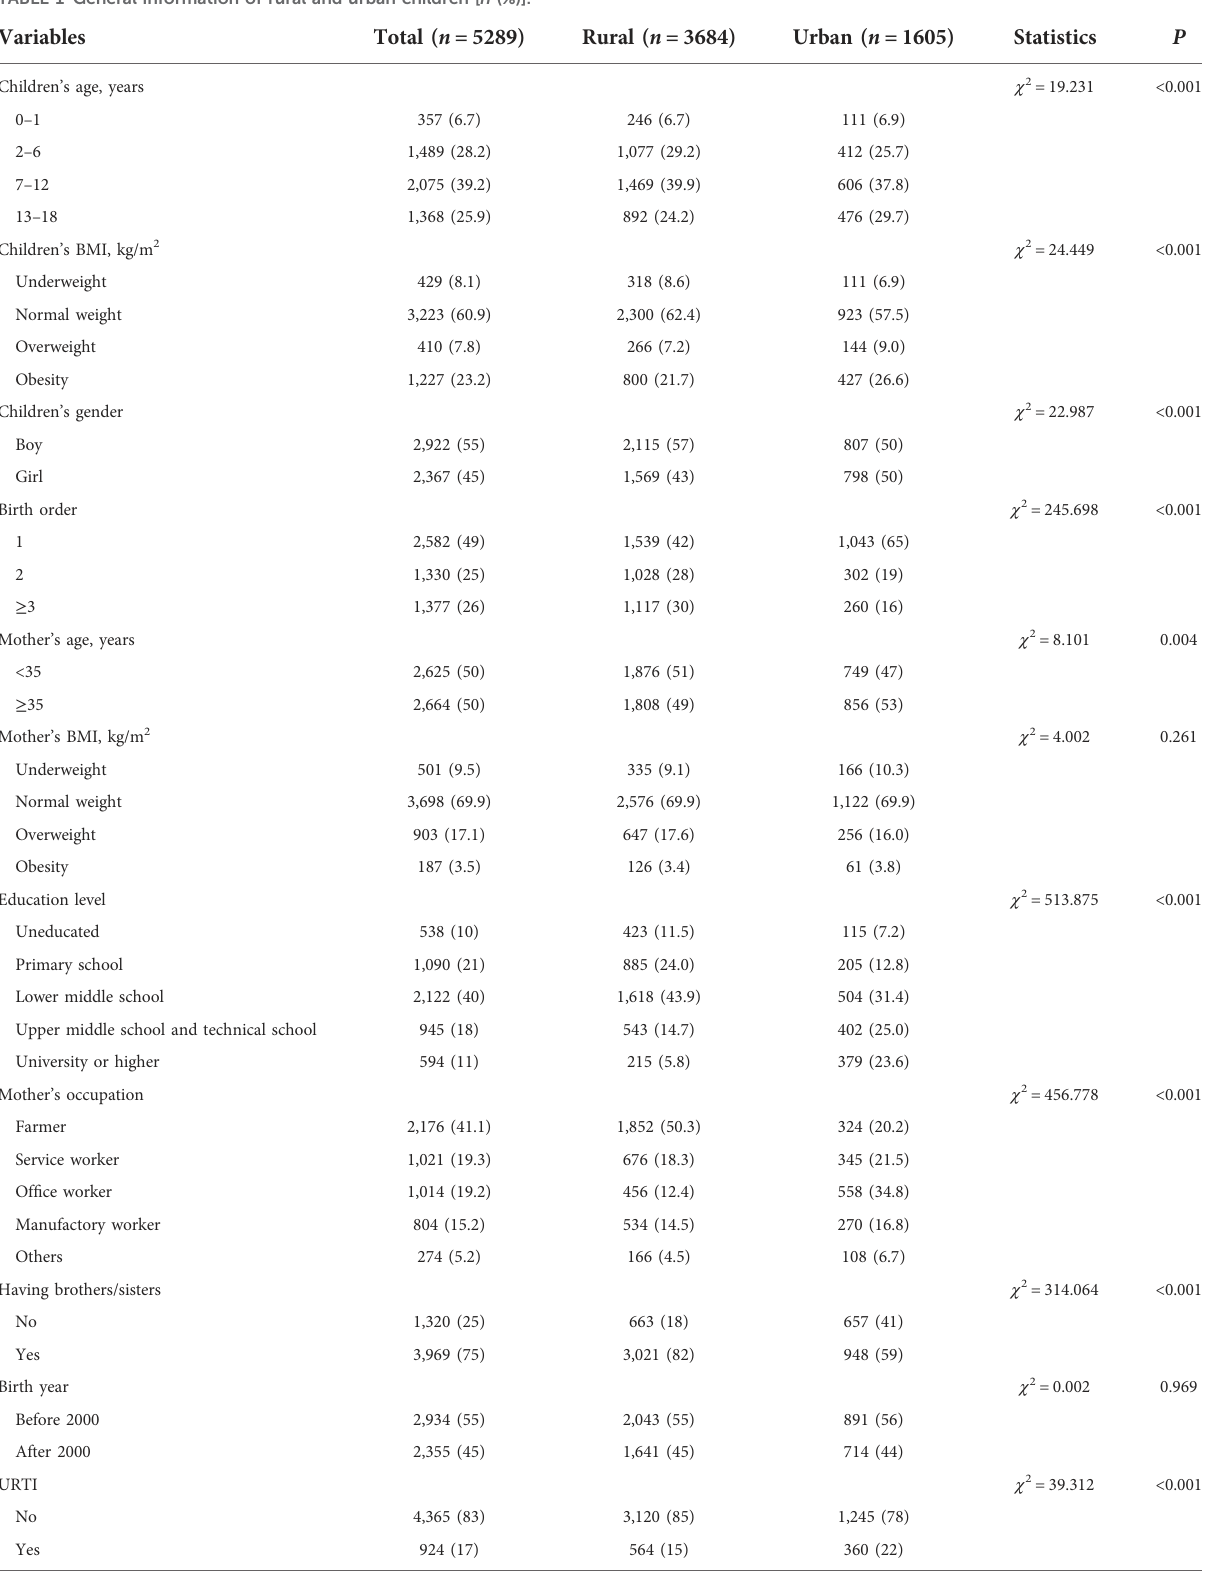
TABLE 1 General information of rural and urban children [ n